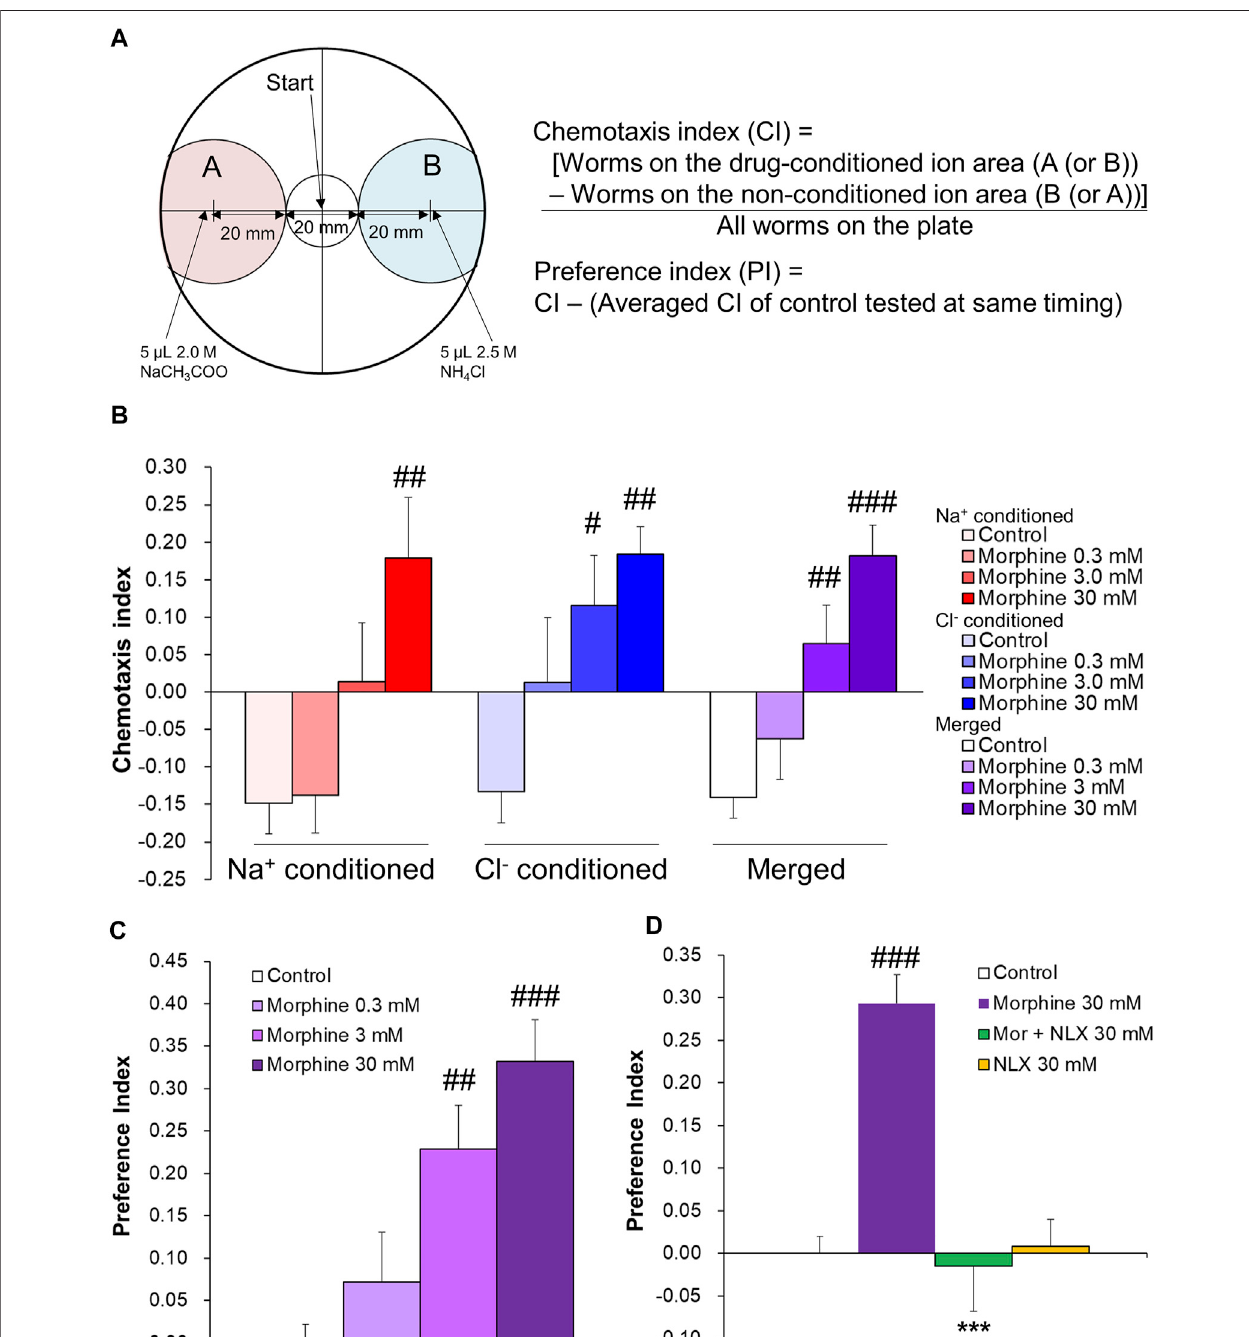
FIGURE1 | Preferencefor morphine-conditioned cue in wildtype C. elegans inthe CCP tests. (A) Testing plate and CIand PI formulae. (B) Chemotaxis Index after 1 h of morphine conditioning. One-way ANOVA: Na + -conditioned, F 3,15 (cid:1) 5.52, p (cid:1) 0.009; Cl − -conditioned, F 3,15 (cid:1) 6.00, p (cid:1) 0.007; merged, F 3,34 (cid:1) 10.84, p < 0.0001. (control, n (cid:1) 6; 0.3 mM morphine, n (cid:1) 4; 3.0 mM morphine, n (cid:1) 5; 30 mM morphine, n (cid:1) 4) (C) Preference Index after 1 h of morphine conditioning. One-way ANOVA: F 3,34 (cid:1) 9.657, p < 0.0001. (control, n (cid:1) 12; 0.3 mM morphine, n (cid:1) 8; 3.0 mM morphine, n (cid:1) 10; 30 mM morphine, n (cid:1) 8) (D) Preference Index after 1 h of 30 mM morphineand30 mMnaloxone(NLX)conditioning.Two-wayANOVA:effectofmorphine,F 1,30 (cid:1) 14.84, p (cid:1) 0.0006;effectofNLX,F 1,30 (cid:1) 18.26, p (cid:1) 0.0002;interaction, F 1,30 (cid:1) 20.22, p < 0.0001(control, n (cid:1) 14;morphinealone, n (cid:1) 8;morphine+NLX, n (cid:1) 6;NLXalone, n (cid:1) 6) ## p < 0.01, ### p < 0.001,comparedwithcontrolworms;*** p < 0.001, compared with 30 mM morphine alone-treated